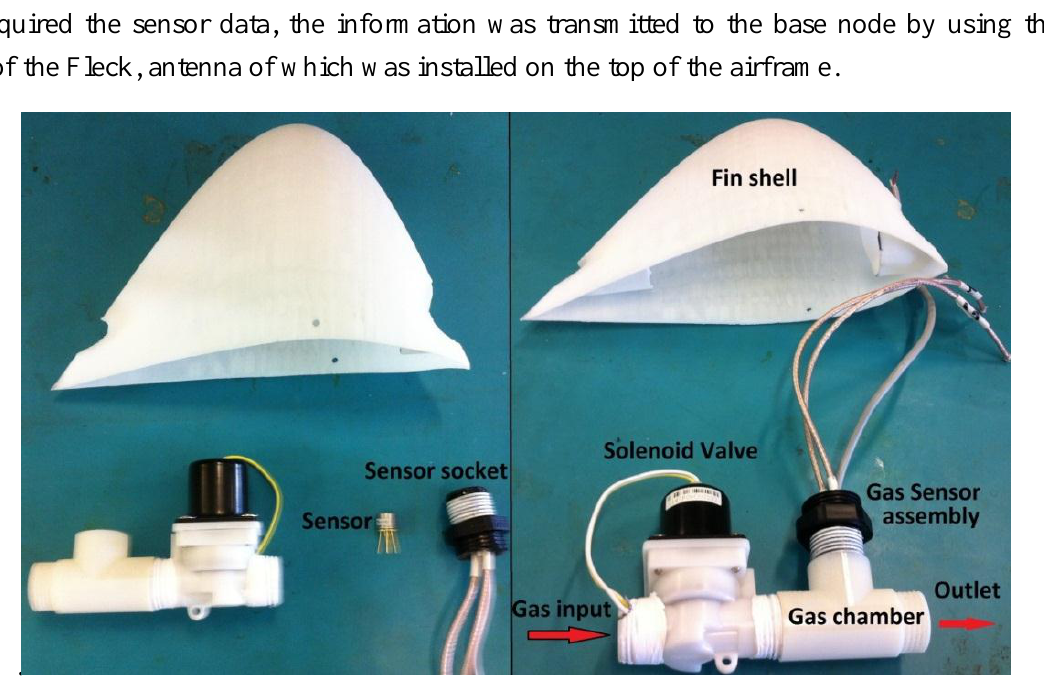
Figure 8. Gas sensing system for airborne applications: aerodynamic fin shell, gas sensor, sensor socket, gas chamber and solenoid